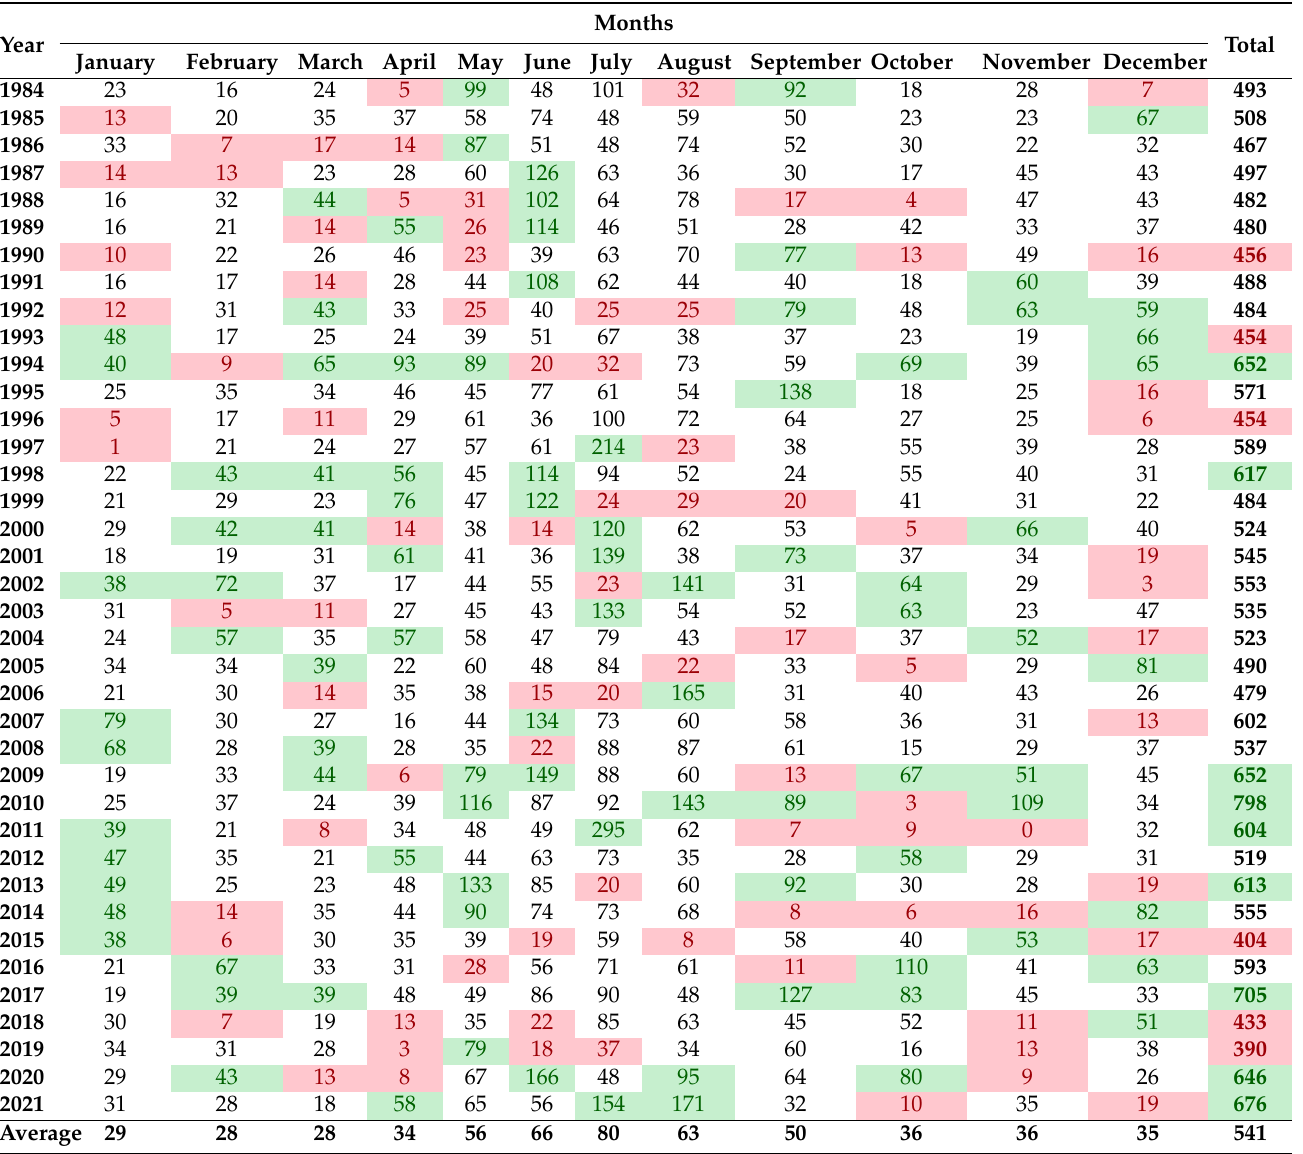
Table 2. Dry, normal and wet months in